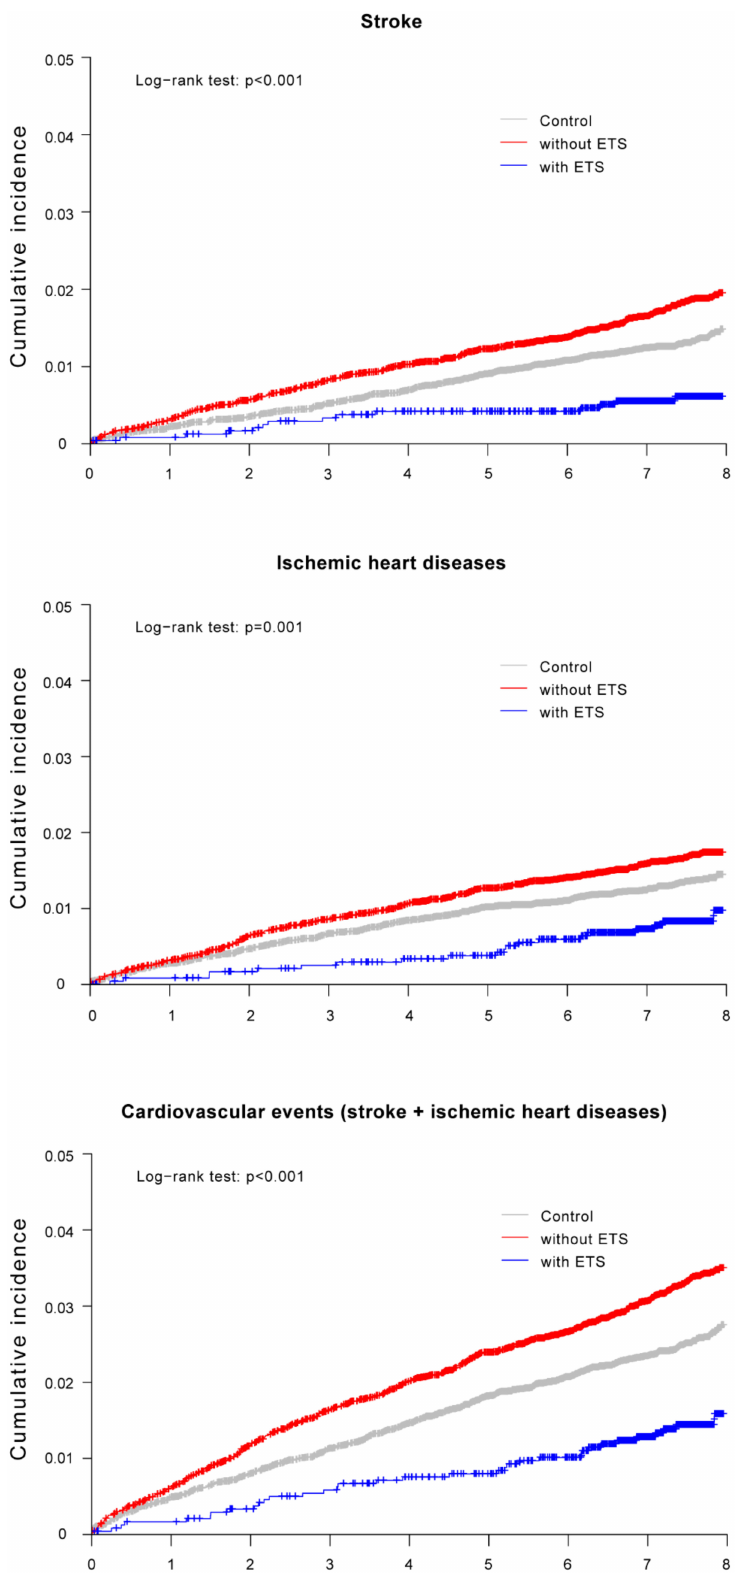
Figure 3. Kaplan–Meier curves with cumulative incidence of cardiovascular events stratified by the presence or absence of hyperhidrosis and Endoscopic thoracic sympathectomy (ETS) status using log-rank